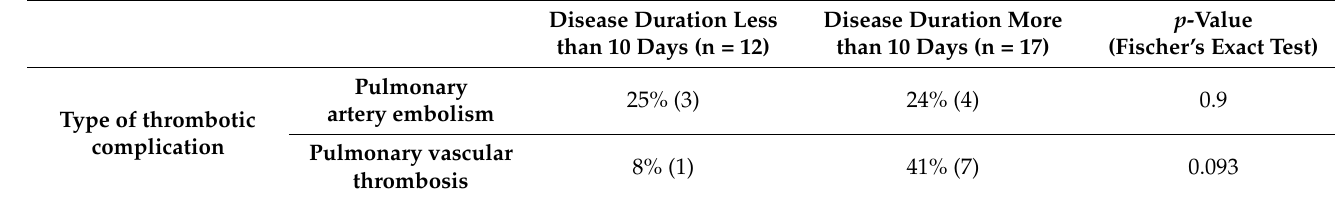
Table 1. Frequency and structure of thrombotic complications in COVID-19 nonsurvivors in relation to disease